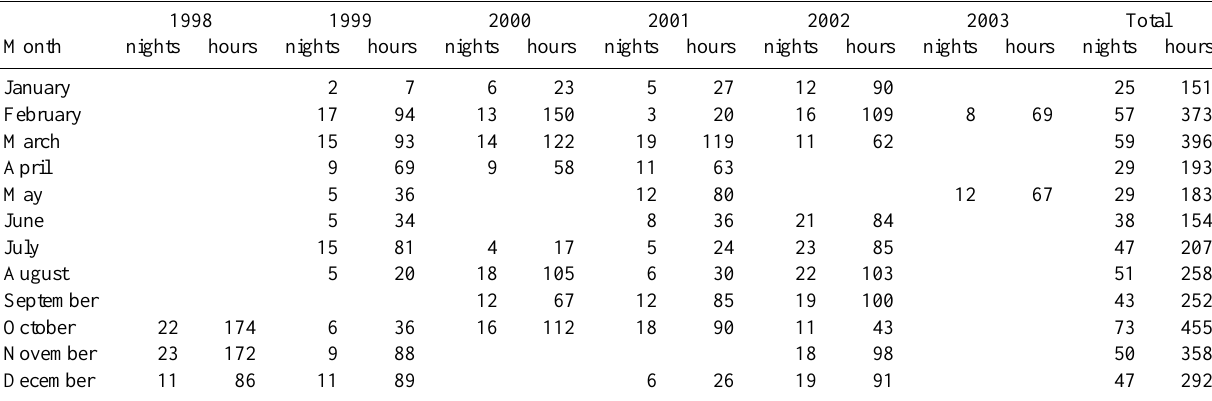
Table 1. Airglow observations.